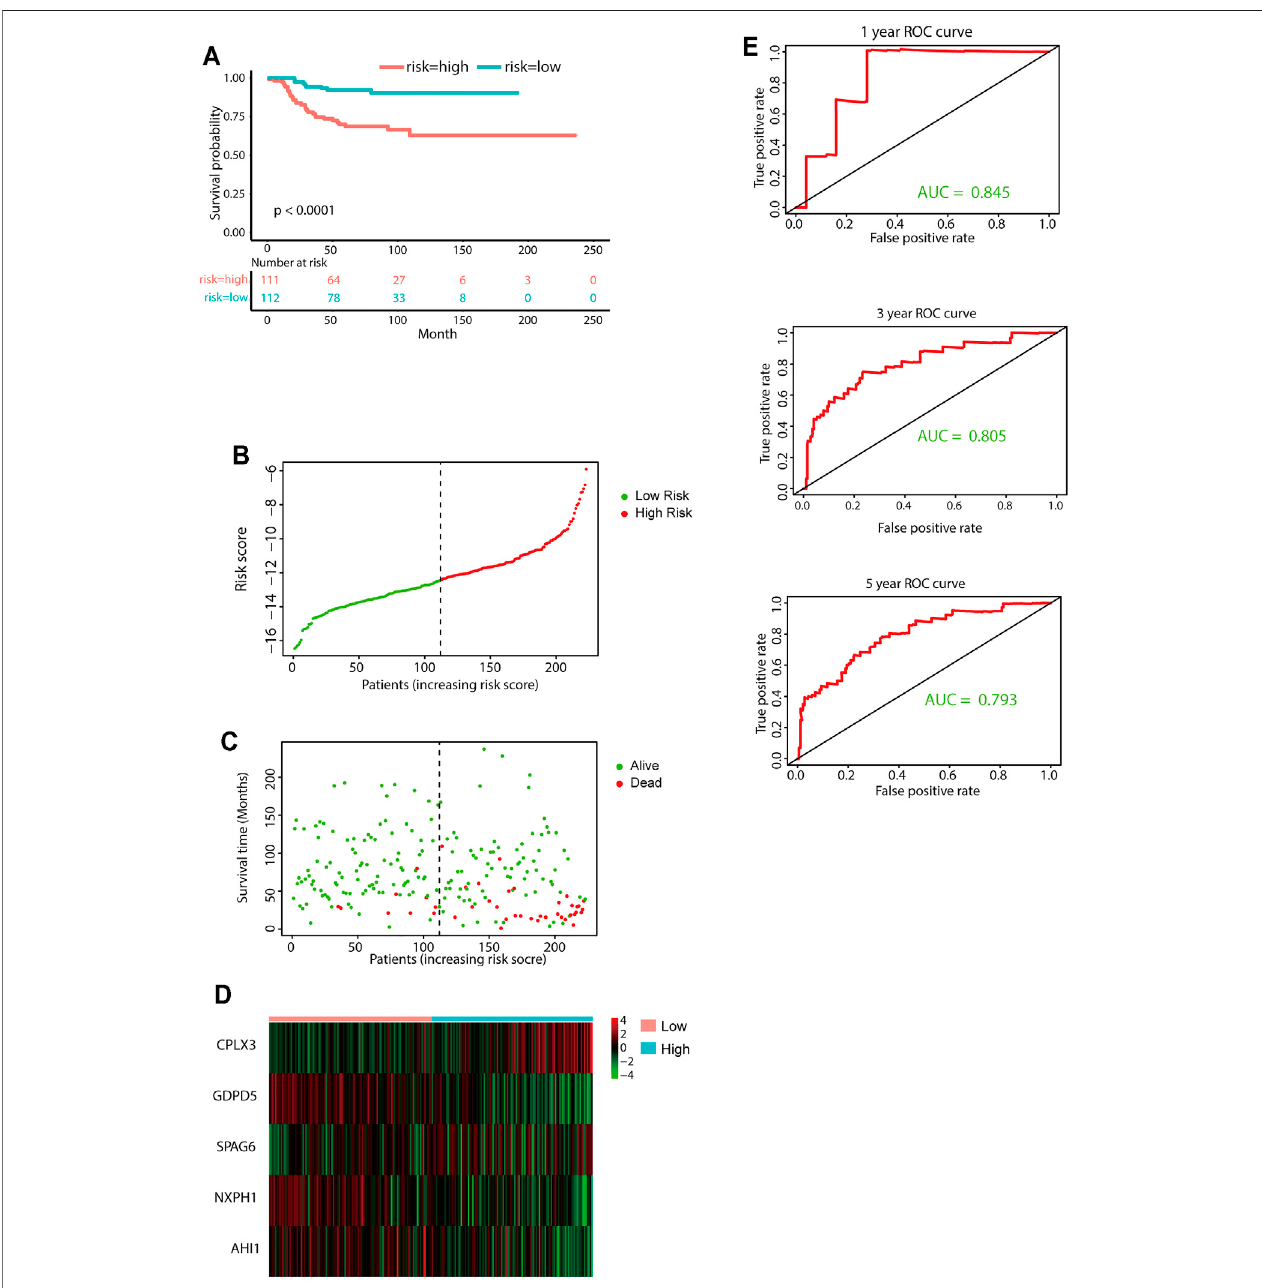
FIGURE 5 | External validation of the fi ve-gene signature. (A) KM curves for overall survival of the two risk groups derived from the fi ve-gene signature in the E-MTAB-8248 data set. The p -value was calculated by the log-rank test. (B-D) Distribution of the risk score (B) , the associated survival data (C) , and the fi ve-gene mRNAexpression (D) intheE-MTAB-8248dataset. (E) ROCcurvesfor1-year,3-year,and5-yearoverallsurvivalpredictionsforthe fi ve-genesignatureintheE-MTAB- 8248 data